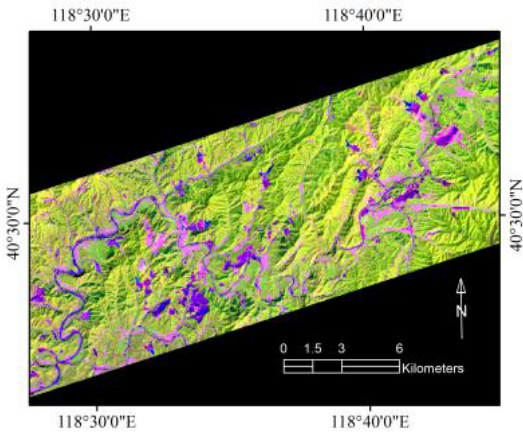
Fig.1 Landsat 8 OLI image of the study area